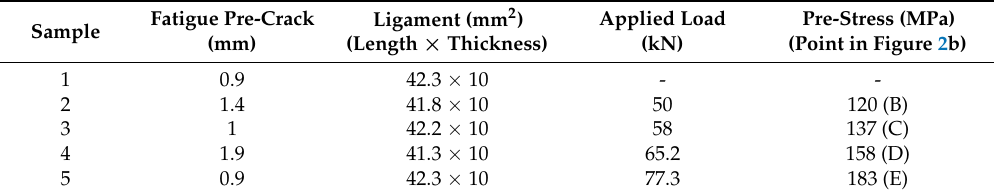
Figure 2. The fabrication of a pre-stressed specimen for fatigue testing: ( a ) E-CT specimen (in mm); ( b ) specimen with a fatigue pre-crack; and ( c ) application of pre-stress. Table 2. The pre-stresses applied to Extended-compact tension (E-CT) samples for fatigue